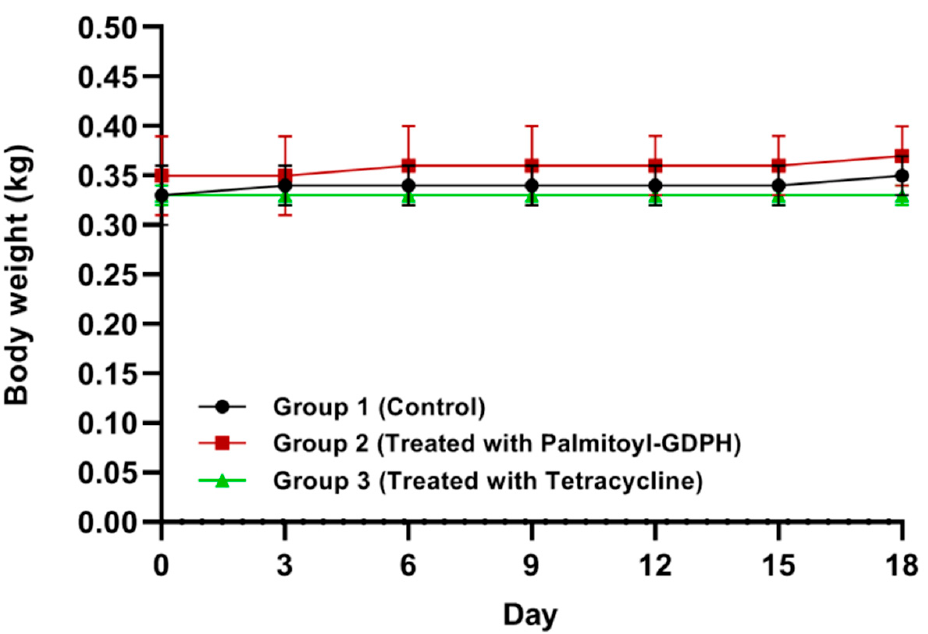
Figure 2. Body weight changes of rats throughout the experimental period.